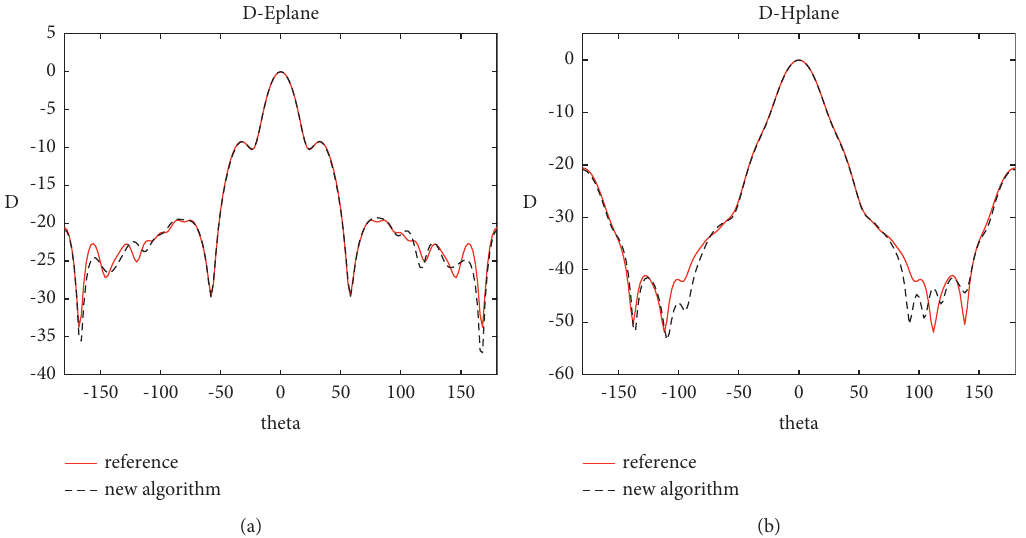
Figure 22: The obtained radiation pattern of horn antenna by adopting the proposed algorithm. (a) E-plane. (b)